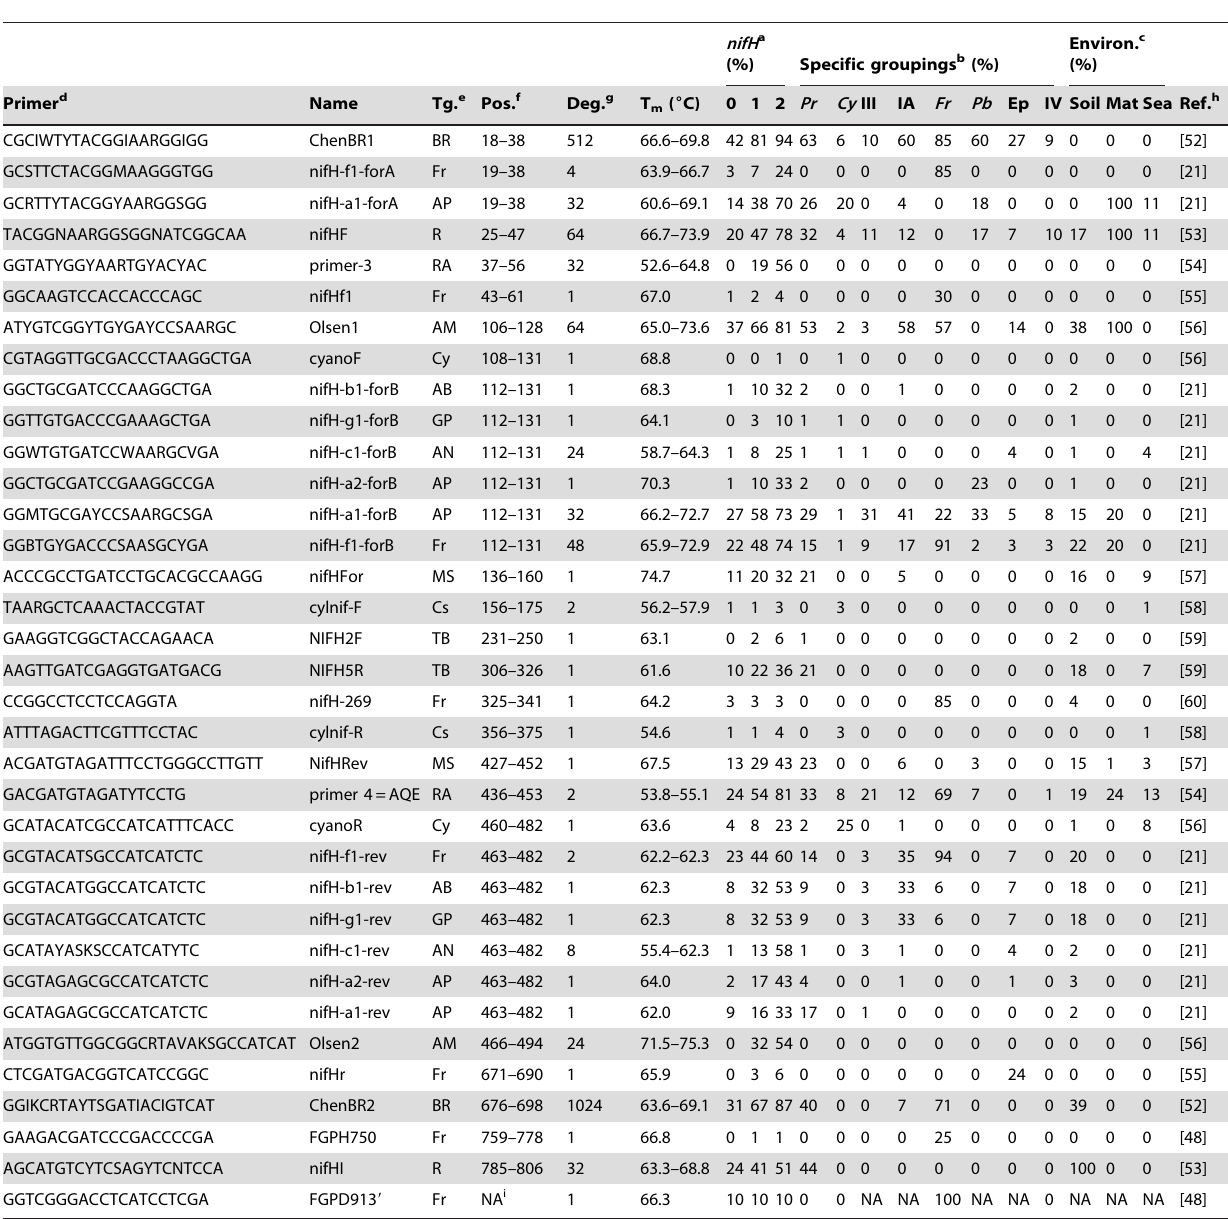
Table 3. Properties of group-specific primers and their coverage for phylogenetic and environmental groupings in the nifH